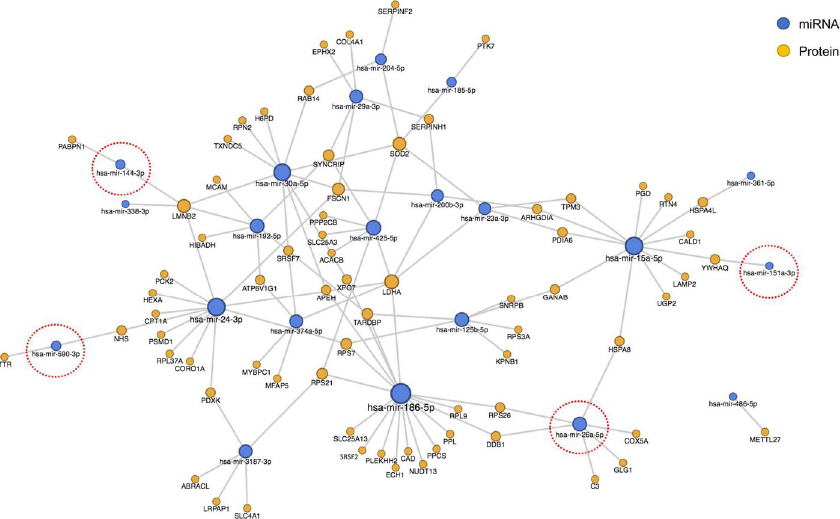
Figure 6. Network plot showing the interactions in pathological kidney tissue among the proteins exclusively present or up-regulated in the affected specimens and the miRNAs identified in the study, according to miRNet database. MiRNAs circled in red represent the only four miRNAs regulating exclusively the proteins related to the affected cats and none of those found in the